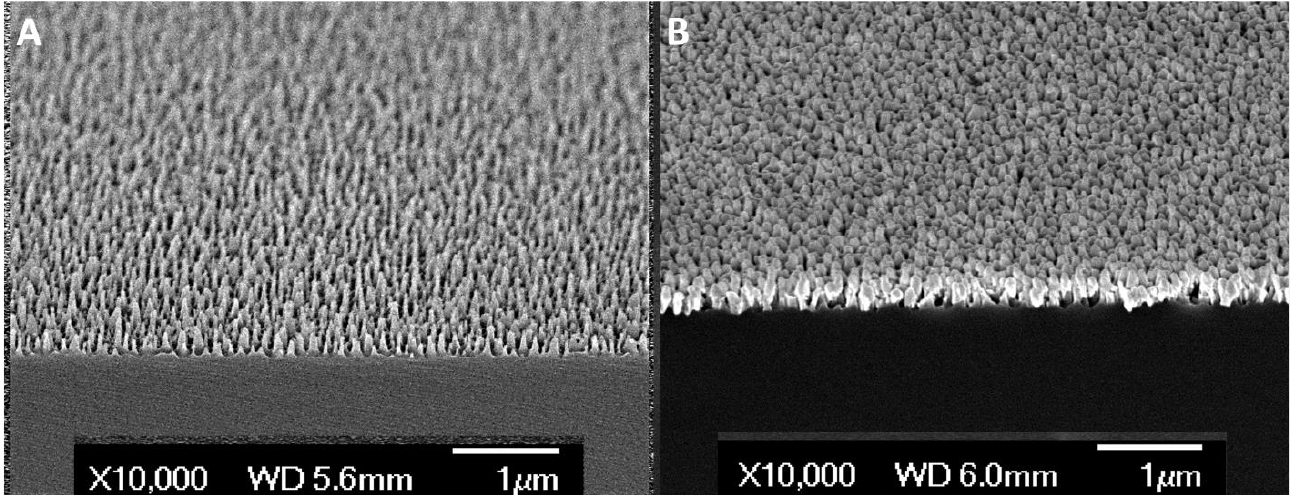
Figure 2. FE-SEM cross-sectional view of silicon nanopillar (SNP) structure. ( A ) Clean SNP without metal coating. ( B ) Silver coated silicon nanopillar (SCSNP).